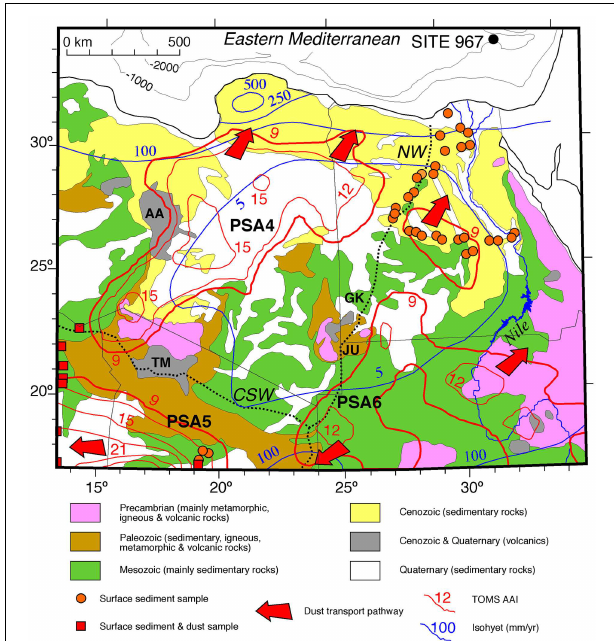
FIGURE 1 | Geological sketch map of the NE Sahara, with indication of mean annual precipitation (blue contours; Petit-Maire and Guo, 1997), total ozone mapping spectrometer (TOMS) annual aerosol index (red contours; Goudie and Middleton, 2001), preferential dust source areas (PSAs, Scheuvens et al., 2013) and the main paths for eolian dust transportation (red arrows; Trauth et al., 2009; Varga et al., 2014). Orange circles indicate the locations of surface sediment samples studied by Lyons et al. (2010), and red squares indicate the locations of surface sediment and dust samples studied by Lyons et al. (2012) and Oldfield et al. (2014). AA, Al-Haruj al-Aswad massif; TM, Tibesti massif; JU, Jebel Uweinat; GK, Gilf Kebir; CSW, central Saharan watershed; NW, Nile